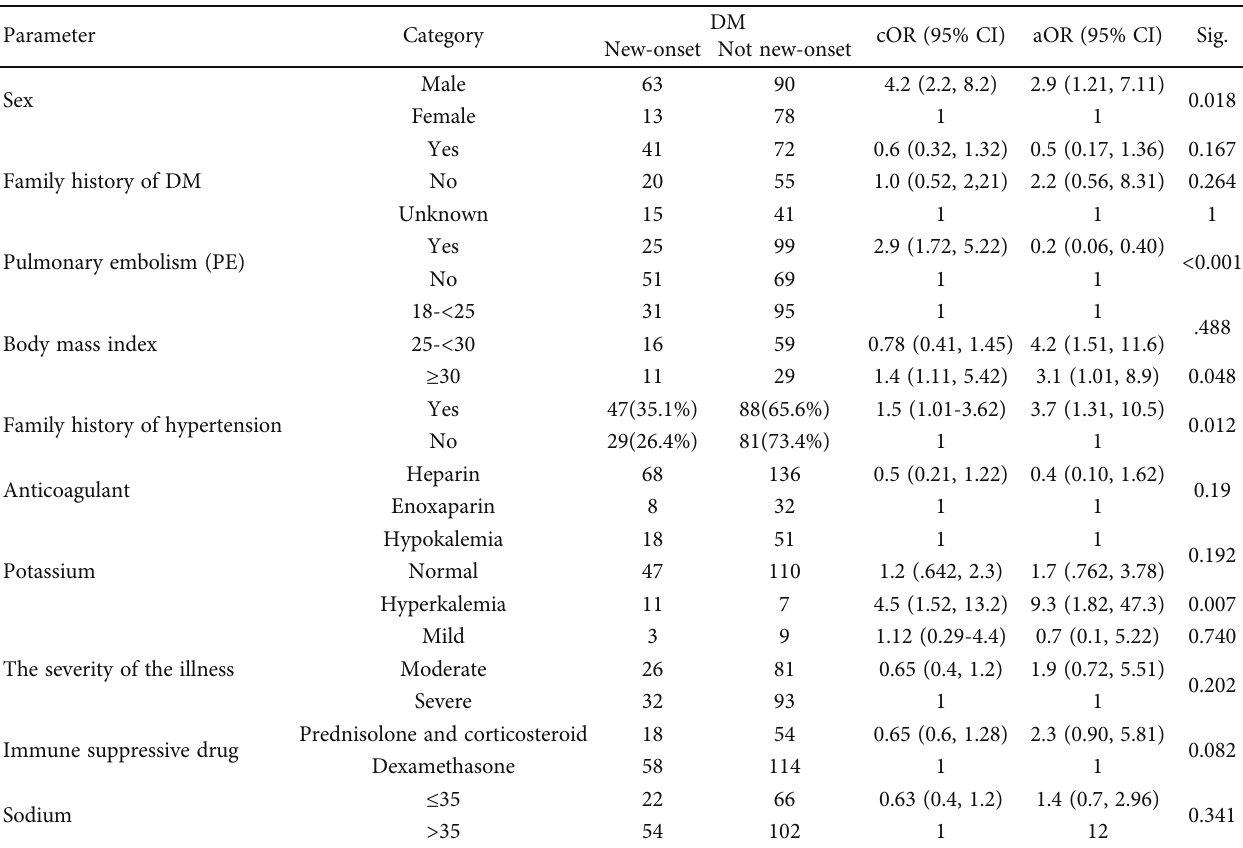
Table 5: Associations between speci fi c variables and new onset of diabetes mellitus in COVID-19 care center, Addis Ababa, Ethiopia, 2022 ( N = 244